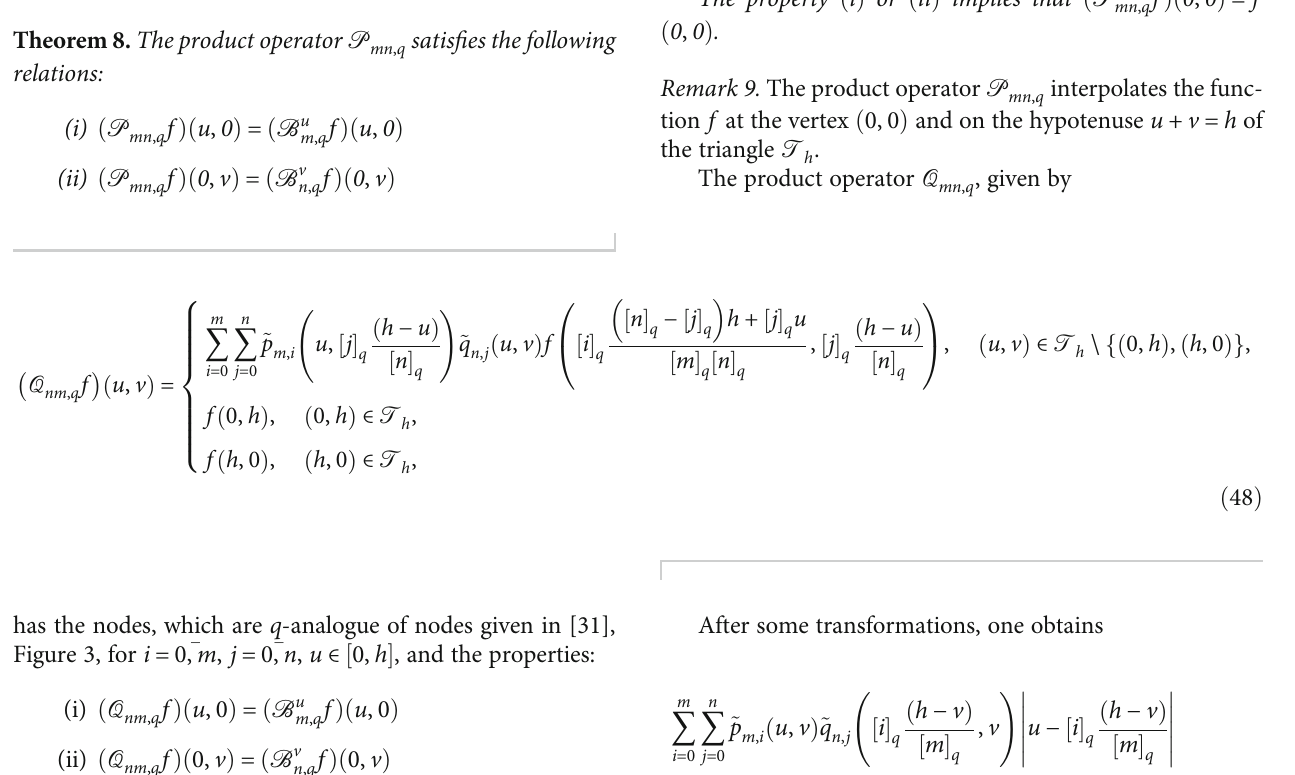
ffiffiffiffiffiffiffiffiffiffiffiffiffiffiffiffiffiffiffiffiffiffiffi v h − u − v ð